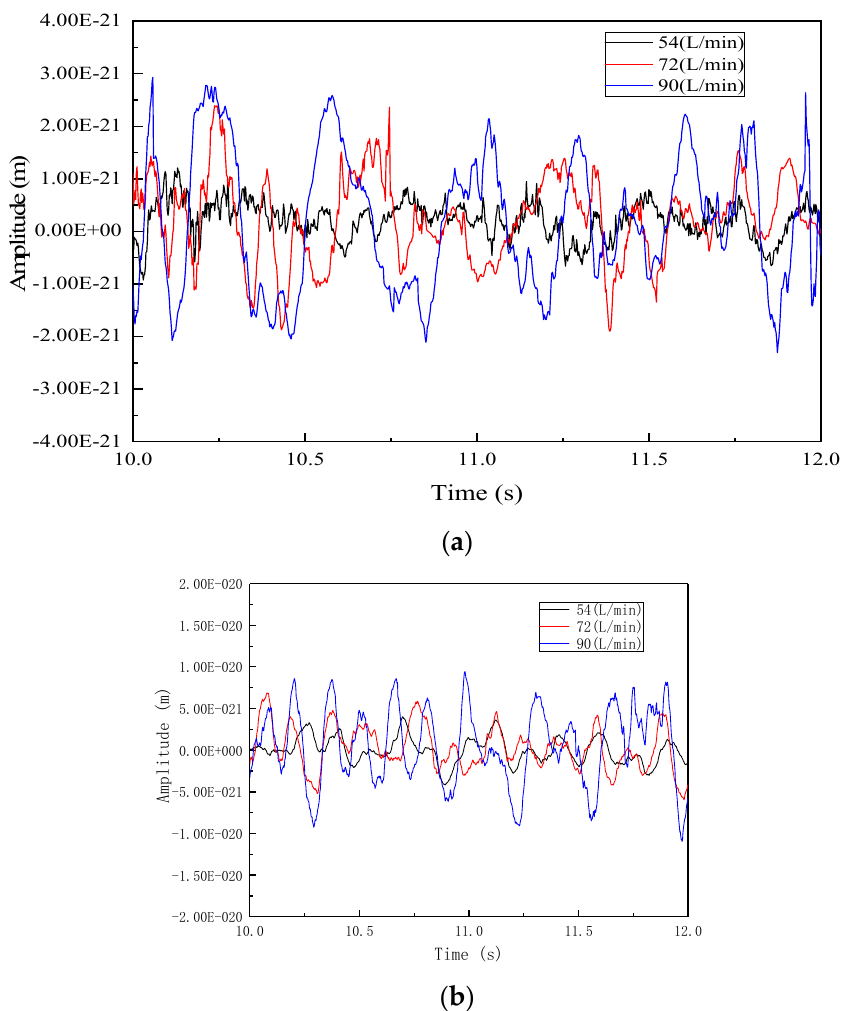
Figure 8. Vibration time-domain diagrams of the bottom of the inner leaching tubing with different water injection rates. ( a ) Direct circulation; ( b ) reverse circulation.